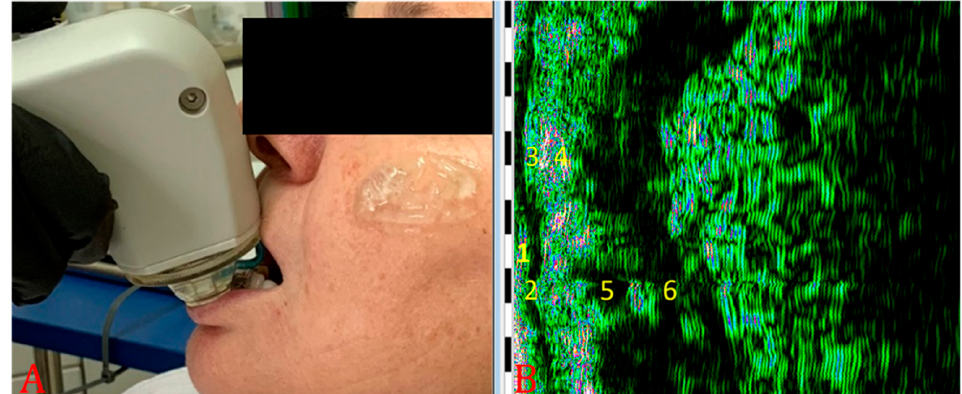
Figure 3. Lower lip HFU examination. ( A ) Transducer position on inner surface of the lower lip, ( B ) the lower lip ultrasound structure: 1—superficial layer of the nonkeratinized epithelium, 2—spinosum and basal layers of the nonkeratinized epithelium, 3—papillary and reticular layers of the lamina propriae, 4—submucosa, 5—minor salivary gland, 6—orbicular oris muscle.